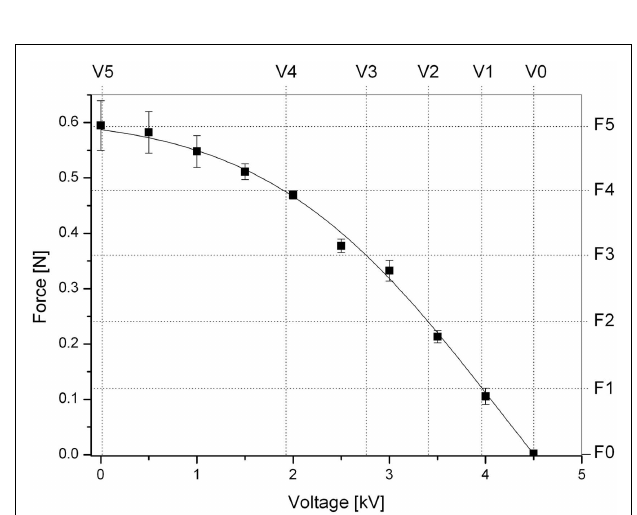
FIGURE 8 | Force perceived by the user as a function of the applied voltage while the finger is kept at a constant position corresponding to the maximum displacement (3.25mm) that the actuator is capable of producing .The five levels of force F1–F5 used for the psychophysical test are indicated. Error bars represent a 95% confidence interval. A fitting line of the experimental data is used as a guide for the eye.